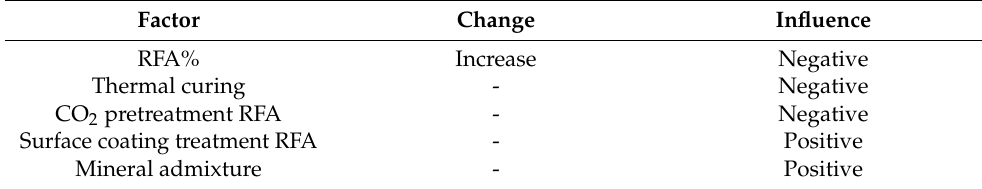
Table 3. The influence of different factors on the resistance of RFAc to chloride ion